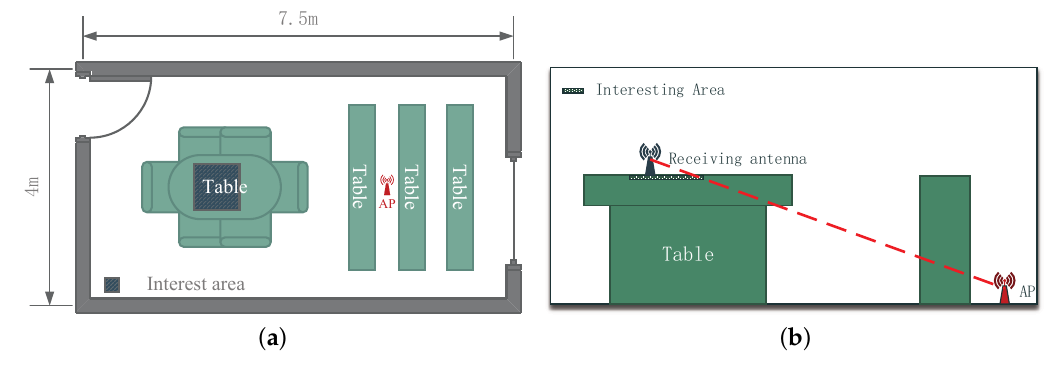
Figure 10. Layout of the meeting room for localization. ( a ) Horizontal direction. ( b ) Vertical direction.